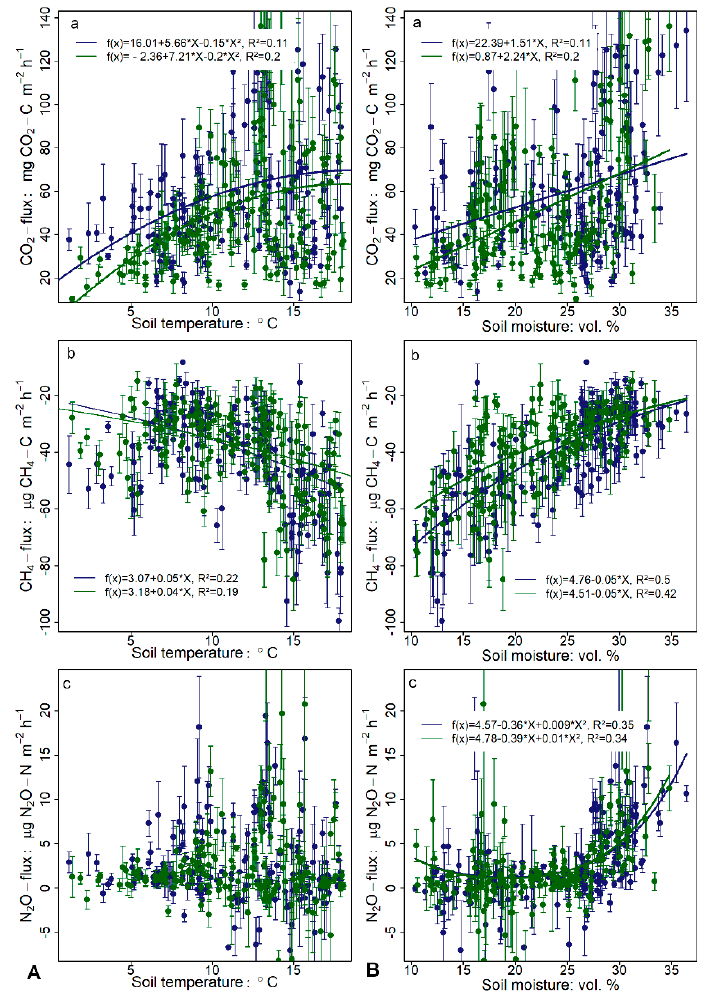
Figure 4. The regressions of soil respiration ( a ), CH 4 fluxes ( b ) and N 2 O fluxes ( c) with soil temperature ( A ) and soil moisture ( B ): Presented are the means of the four different plots (BB control and drought: blue, BF control and drought: green, n = 5–6) on a sampling day with standard errors. The data show 91 measurements from March 2016 to November 2017.